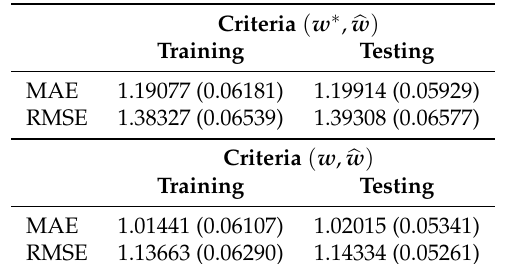
Table 3. Simulated data: means and standard deviations (between brackets) of two goodness-of-fit criteria for the approach based on the 100 generated